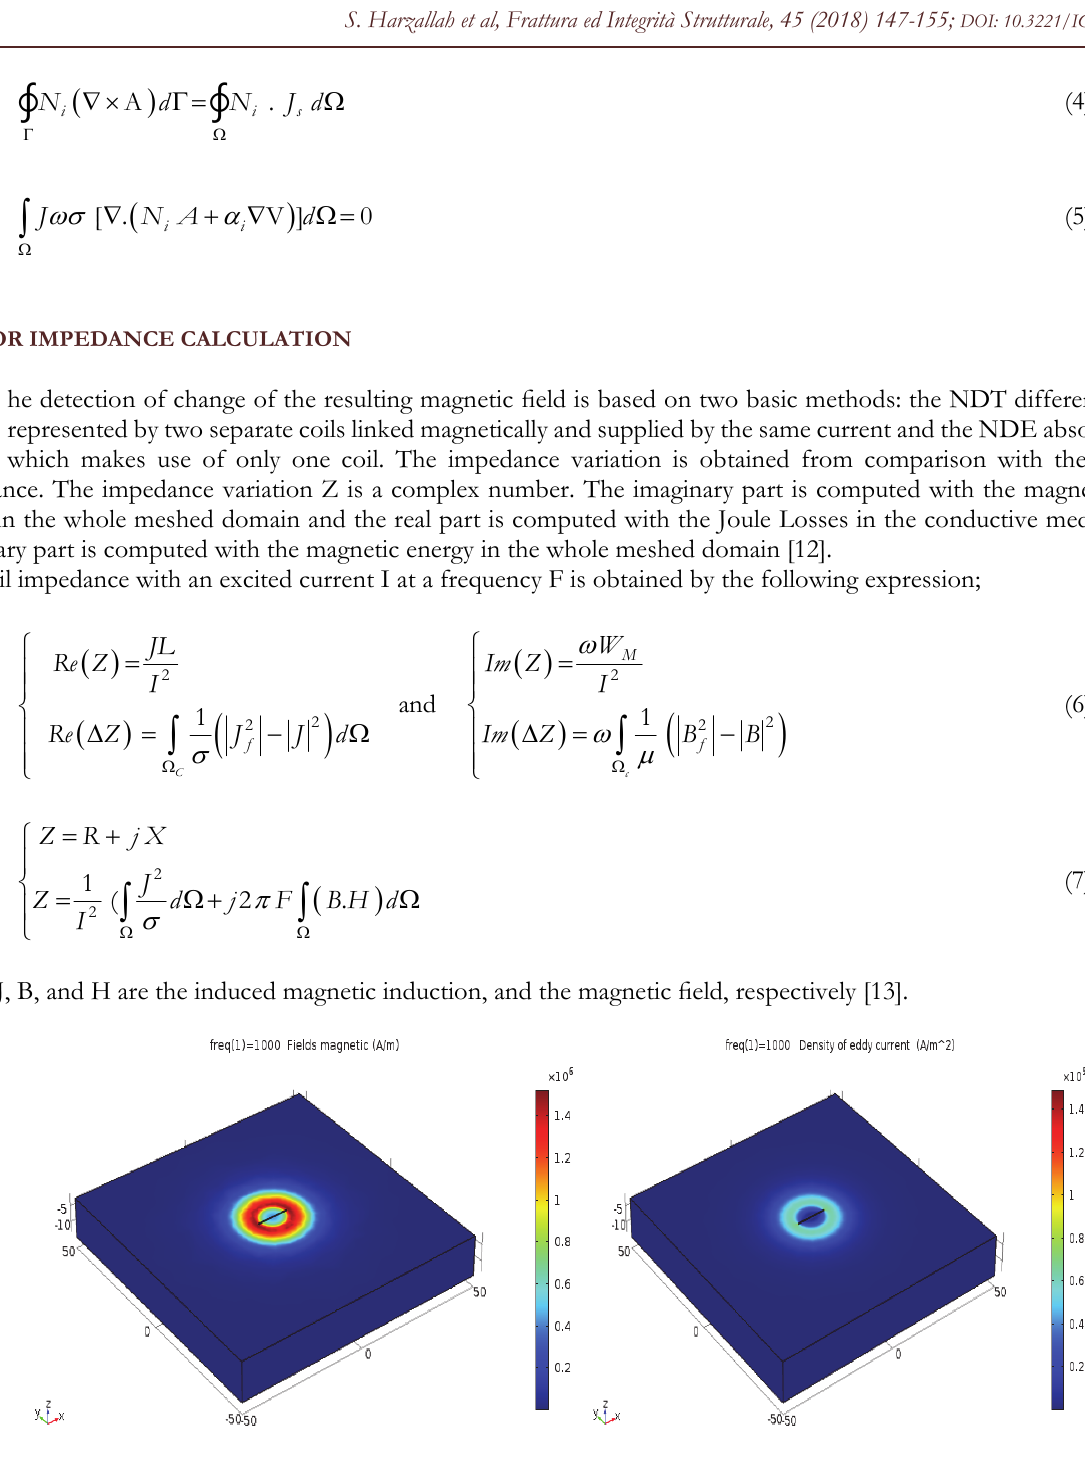
Figure 1: Vector of induction B. Figure 2: Density of the induced